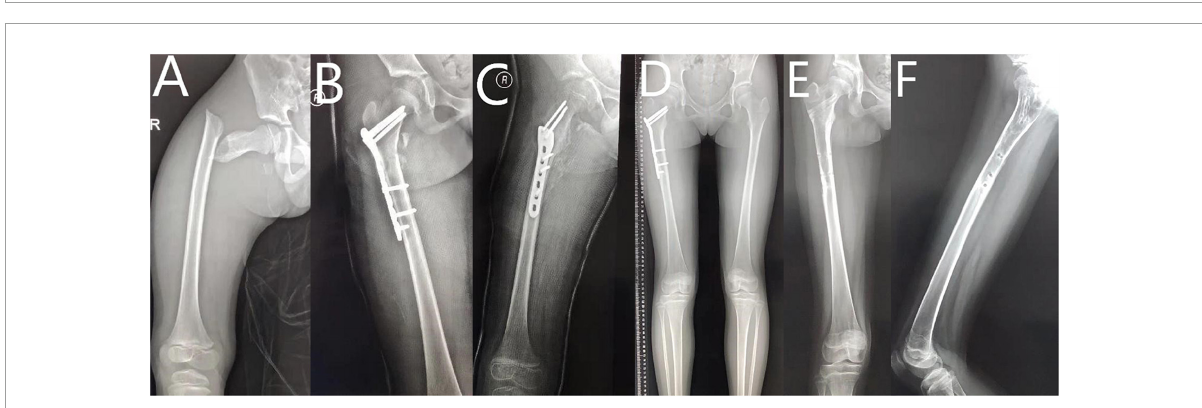
FIGURE2 10 year-old girl with right subtrochanteric fracture treated with locking plate. (A) AP view of femur before surgery. (B) AP view of femur after surgery. (C) Lateral view of femur after surgery. (D) AP view of femur at 6th month follow-up. (E) AP view of femur after implant removal. (F) Lateral view of femur after implant